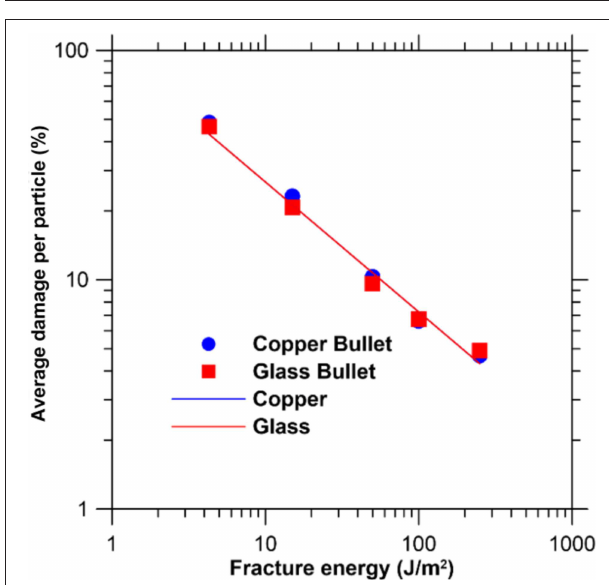
FIGURE 7 | Final average damage per particle in the glass plate with respect to fracture energy for copper and glass bullets. The lines represent a power-law fit in the least-squared